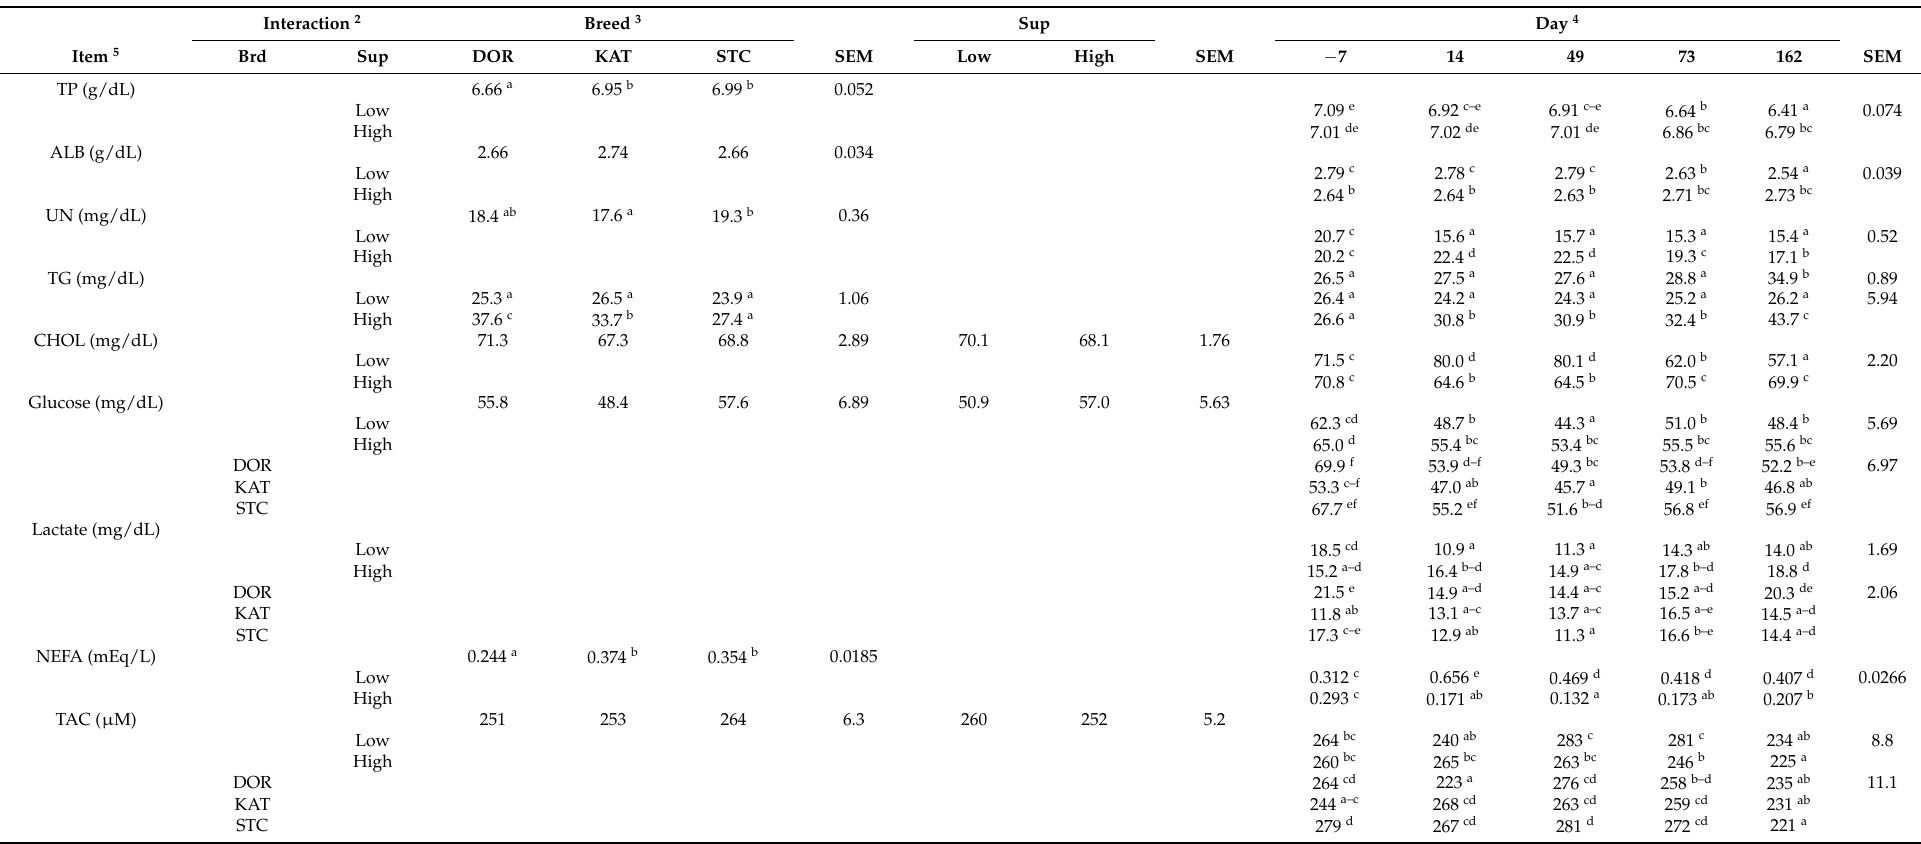
Table 8. Effects of breed, supplementation treatment, and period on blood constituent concentrations in hair sheep 1